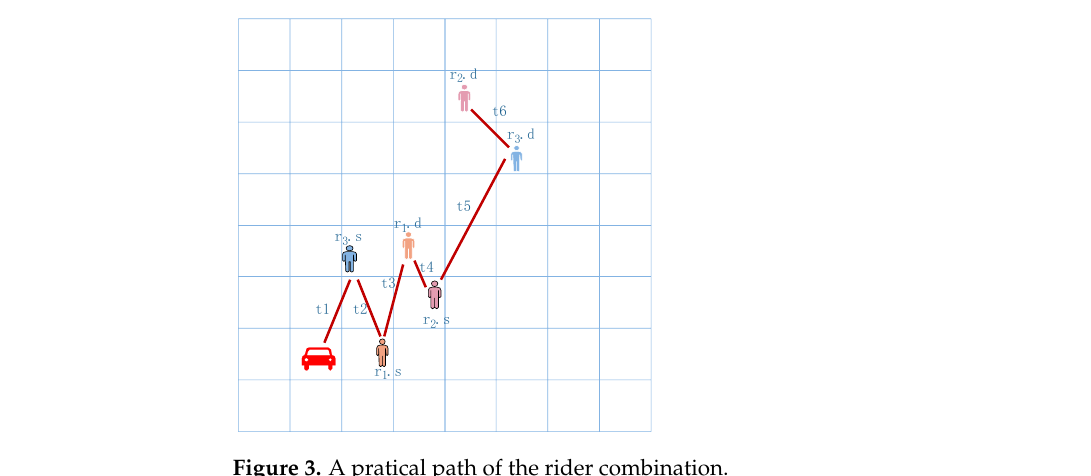
Figure 3. A pratical path of the rider